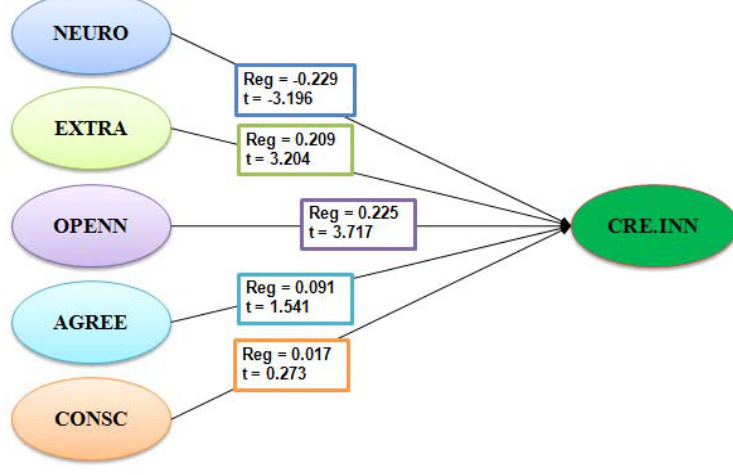
Fig. 3. The results of structural equation